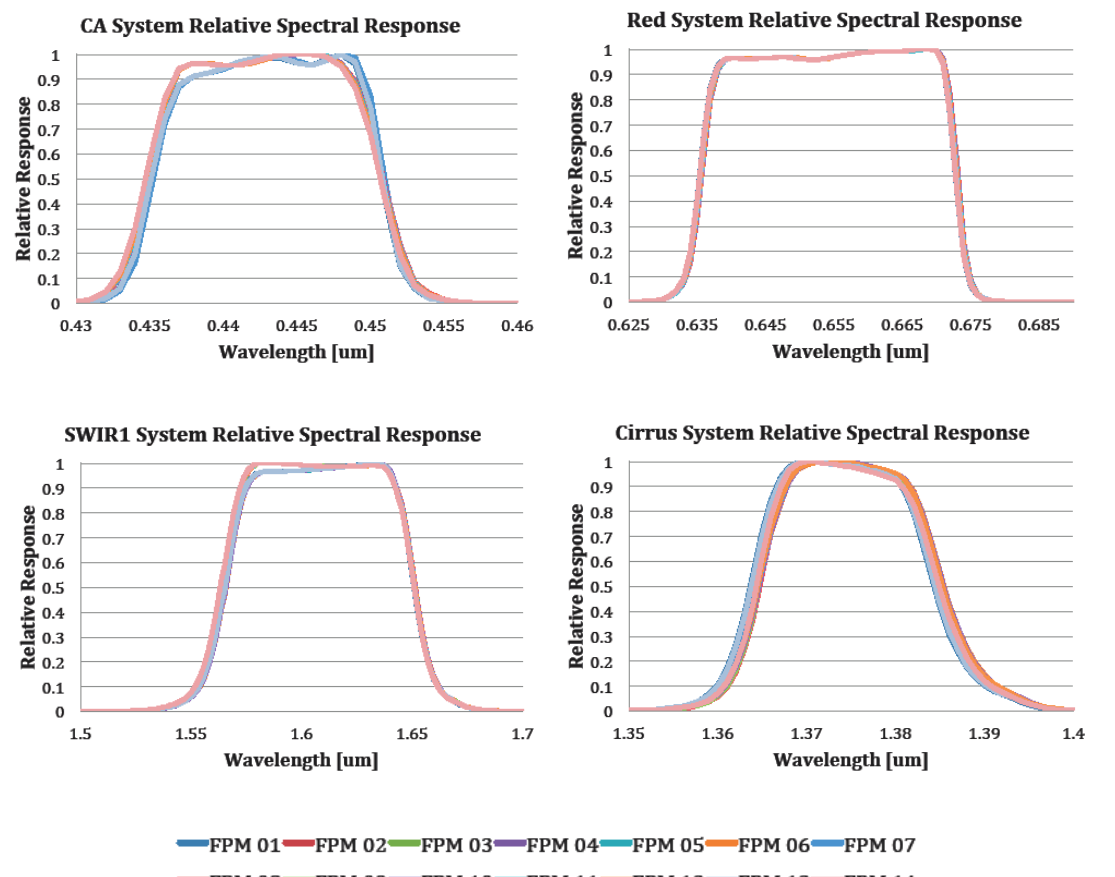
Figure 3. Estimated system-level relative radiance spectral response function of each FPM of the OLI CA ( upper left ), Red ( upper right ), SWIR1 ( lower left ) and Cirrus ( lower right ) bands, bands which illustrate the wafer-to-wafer variability. All of the filters in the Red band originated from the same wafer. The filters in the CA and SWIR1 band come from two different wafers. The filters for the Cirrus band come from three different